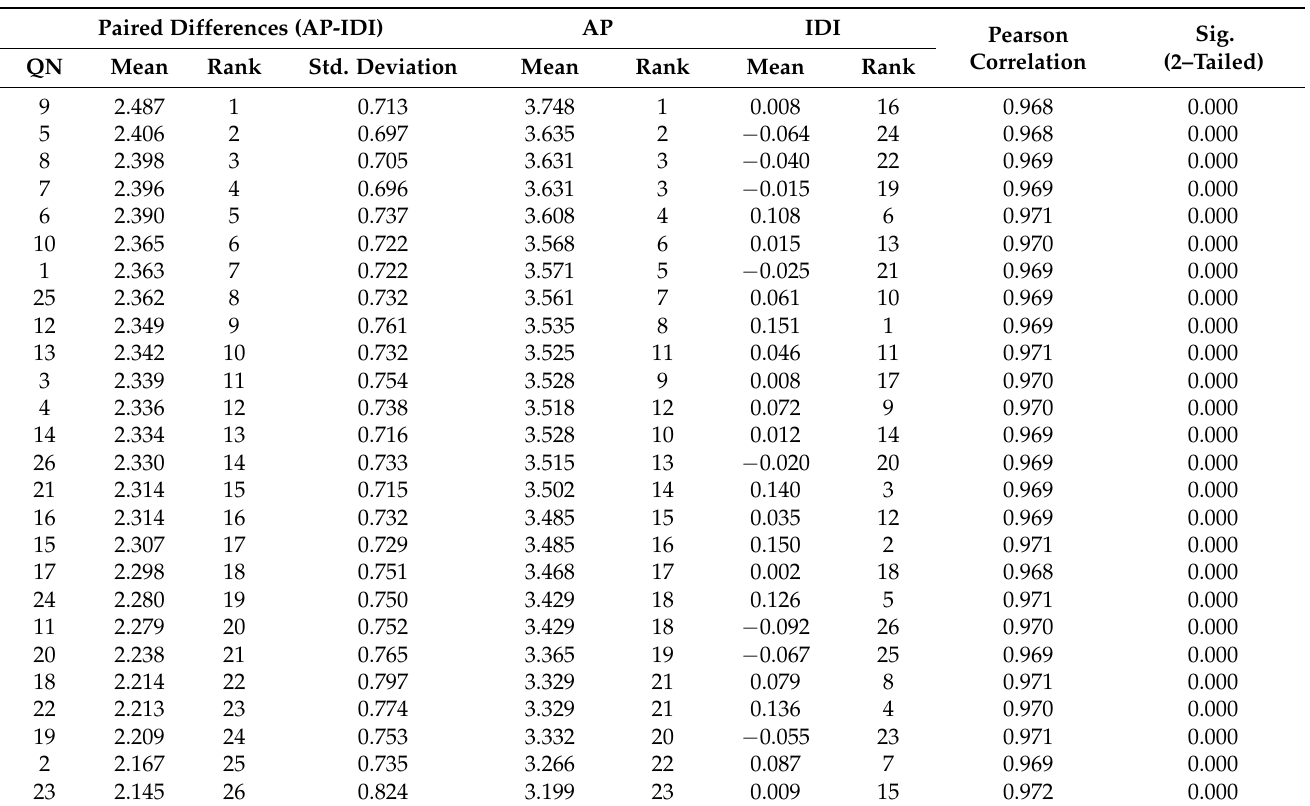
Table 6. Rank means of attribute performance and implicitly derived importance and paired samples ( n = 301).